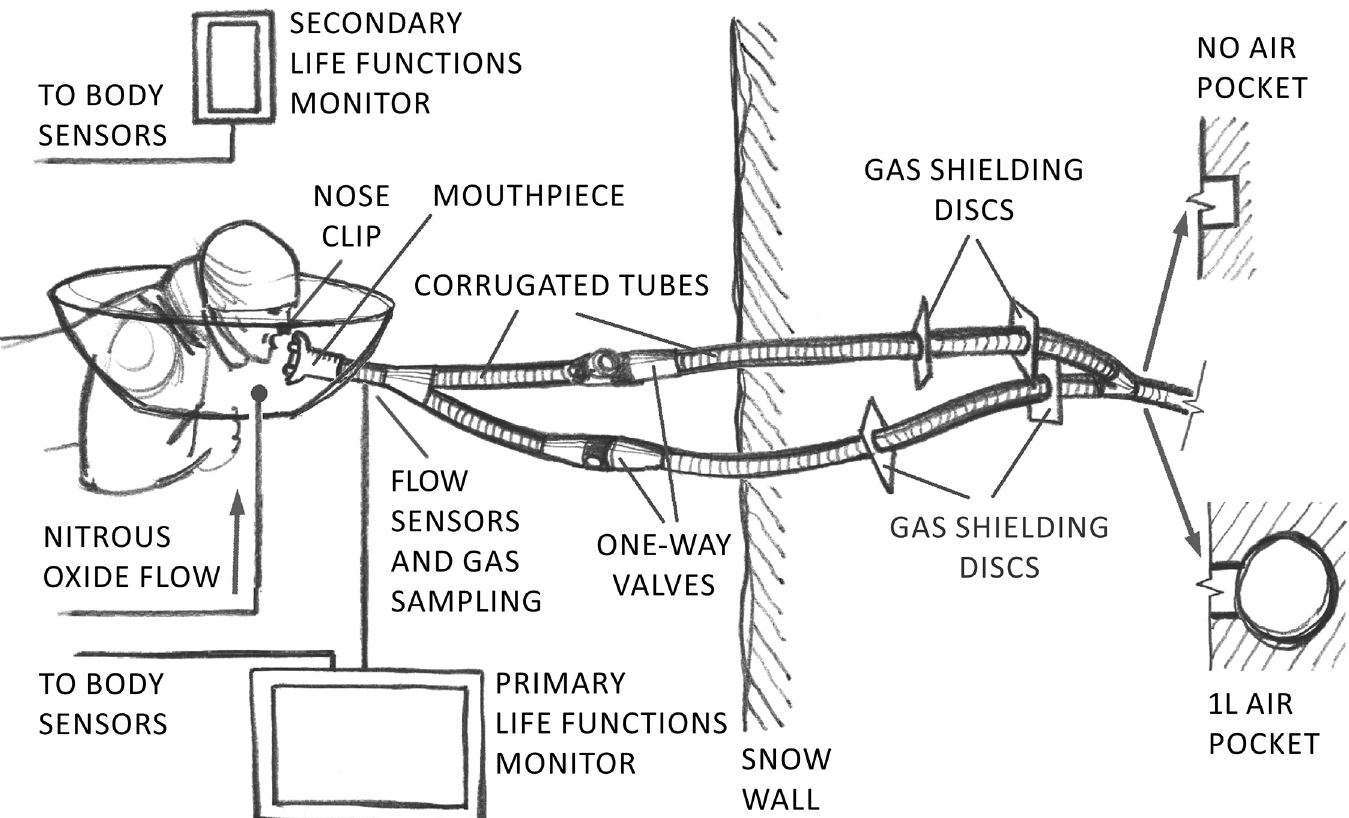
Fig 2. Scheme of the breathing circuit and its installation in the snow. (Illustration: B. Kracmar).